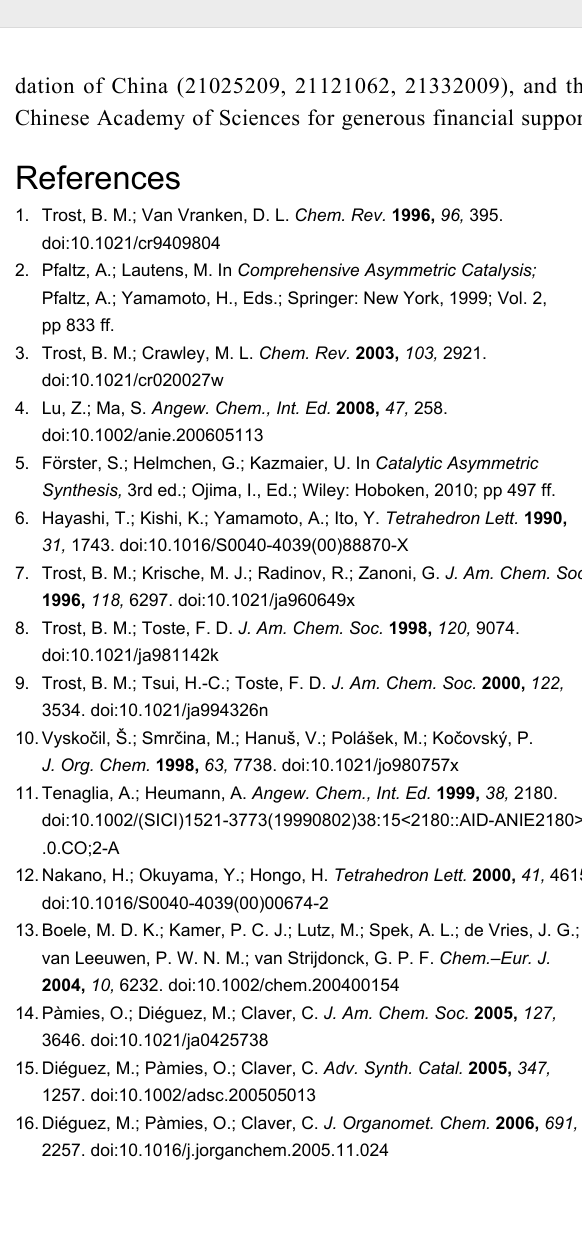
Scheme 3: Comparison of the effect of ligands in the reaction.